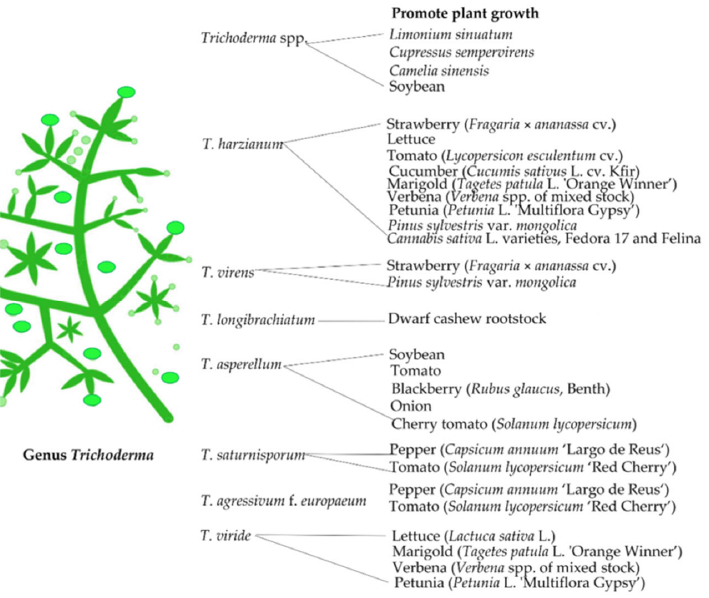
Figure 1. Species of the genus Trichoderma used in the promotion of plant growth.